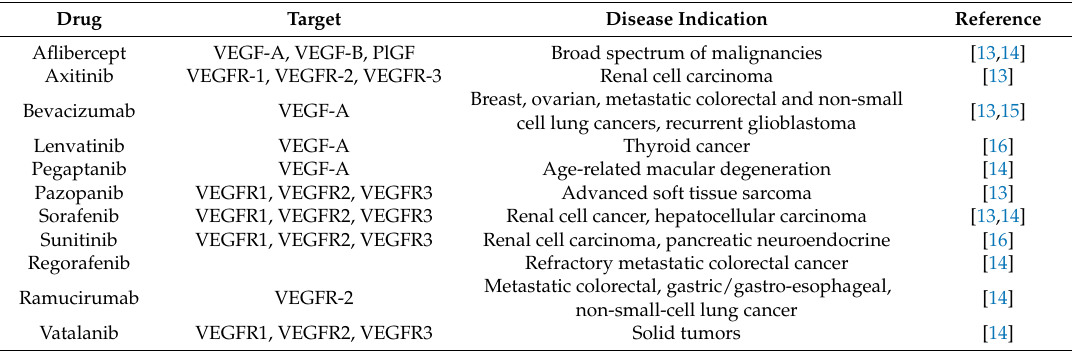
Table 1. Drugs targeting the vascular endothelial growth factor family of ligands and their